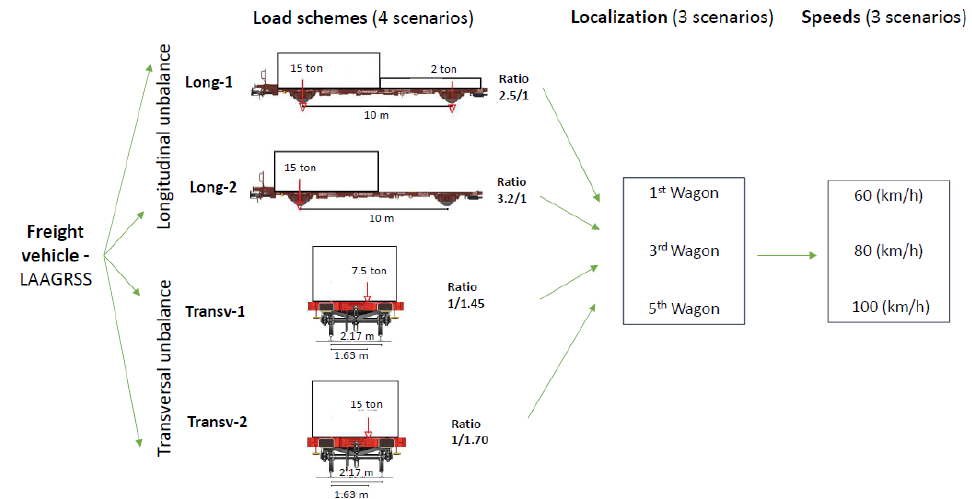
Figure 7. Unbalanced load scenarios.